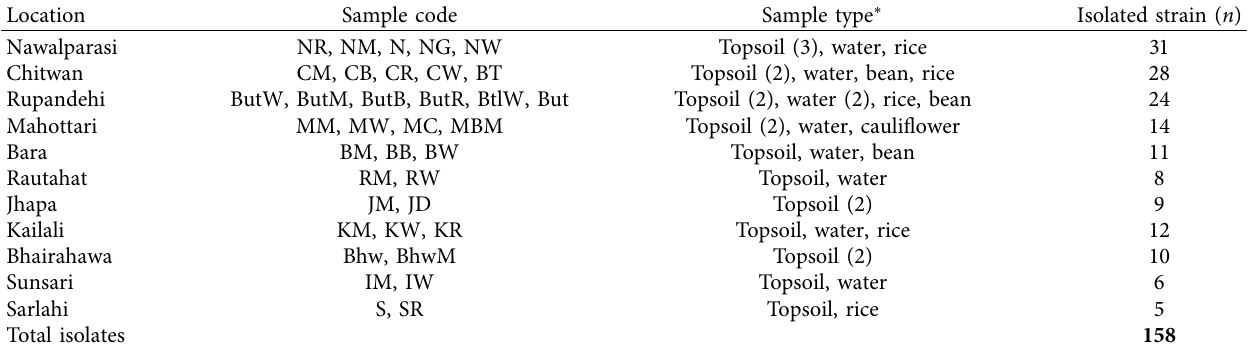
Table 1: Sample description and the total number of isolates.